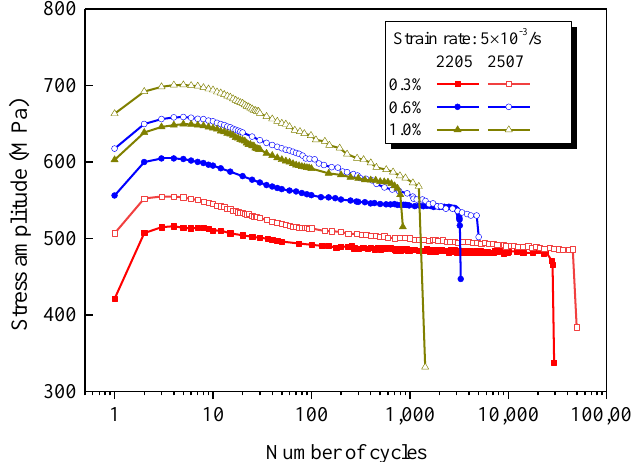
Figure 13. Evolution of interaction between nitrogen atoms and dislocation movements under cyclic loading.